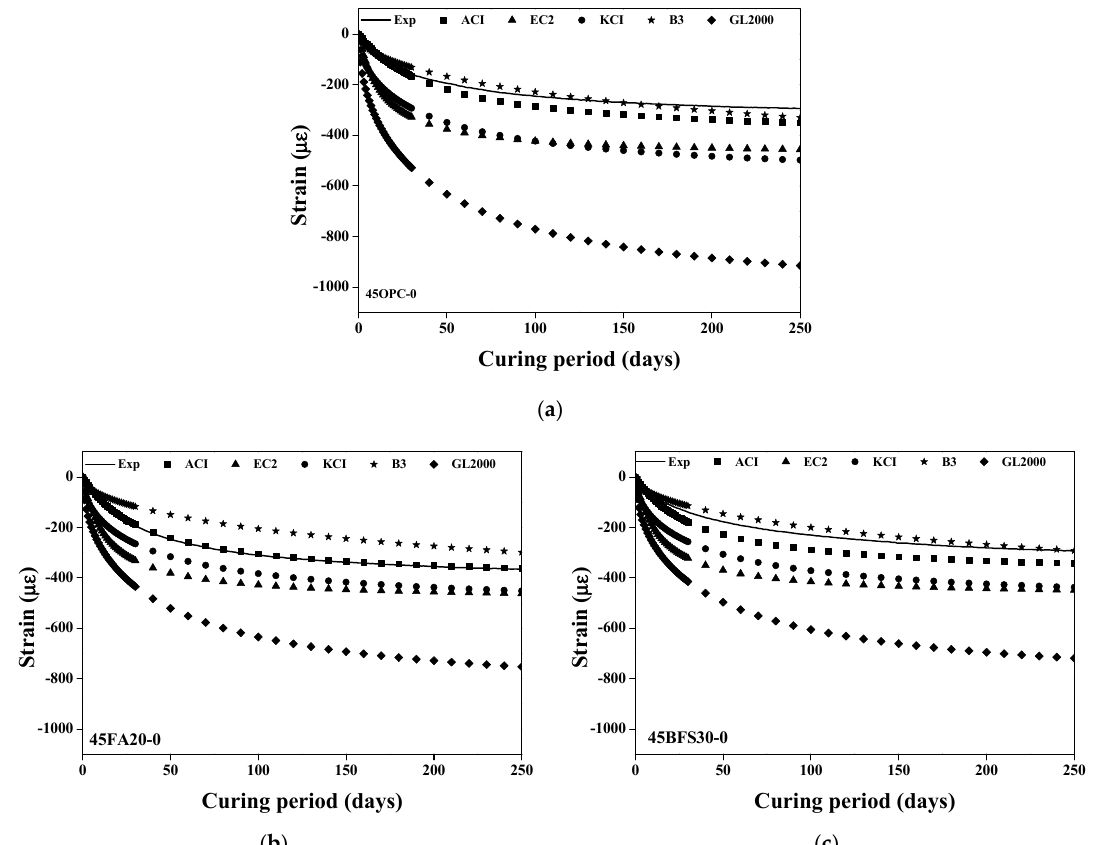
Figure 8. Comparison between test results and predicted value (Steel slag substitution ratio: 0%). ( a ) 45OPC; ( b ) 45FA20; ( c ) 45BFS30.